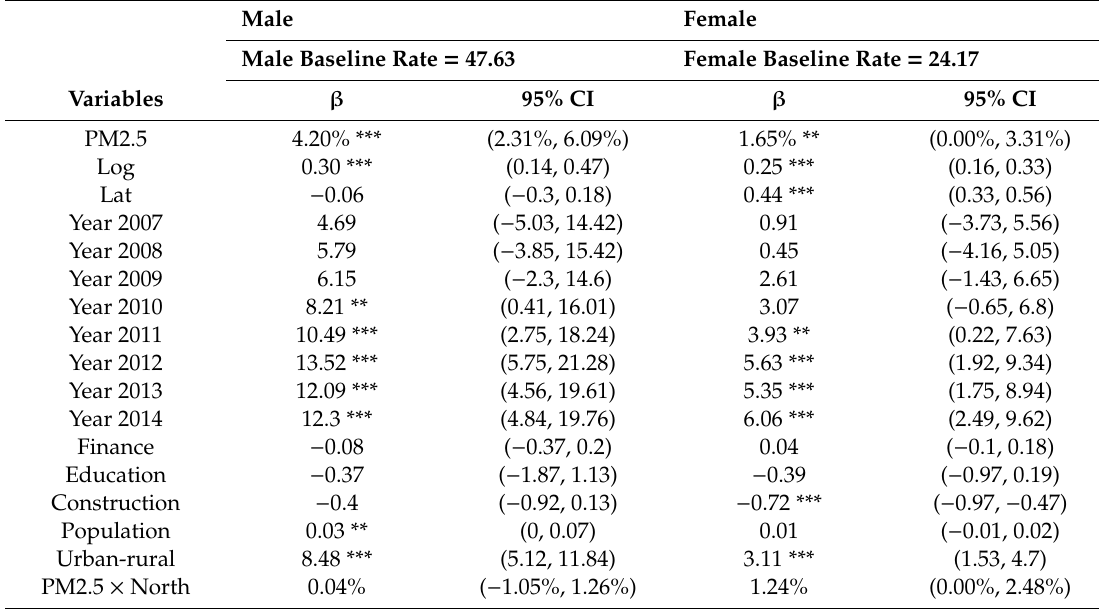
Table 7. Modification e ff ects of region (i.e., North vs. south).